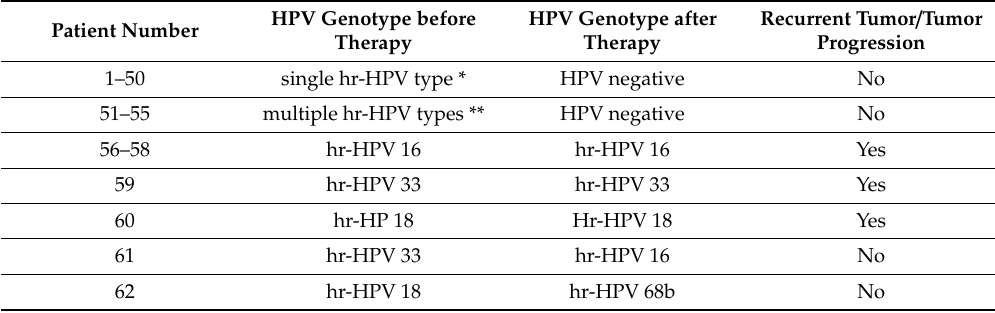
Table 2. Human papillomavirus (HPV) genotypes before and after therapy.